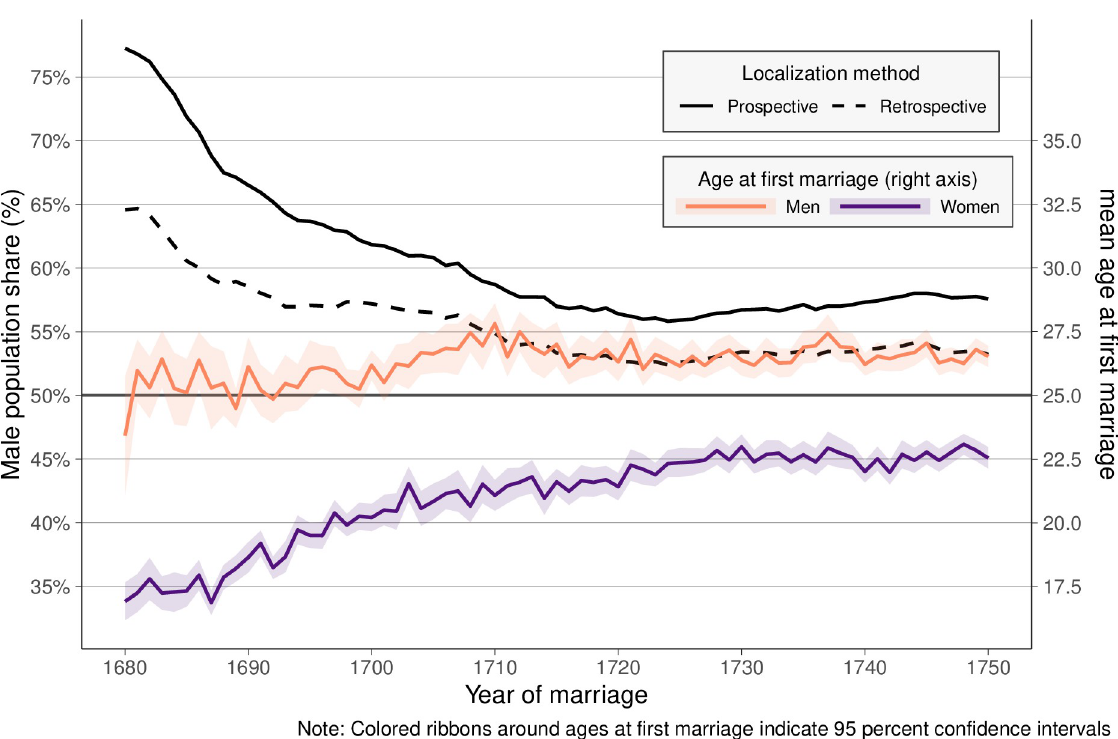
Fig 3. Share of men in the unmarried population and mean age at first marriage by sex. PRDH data, 1680–1750.